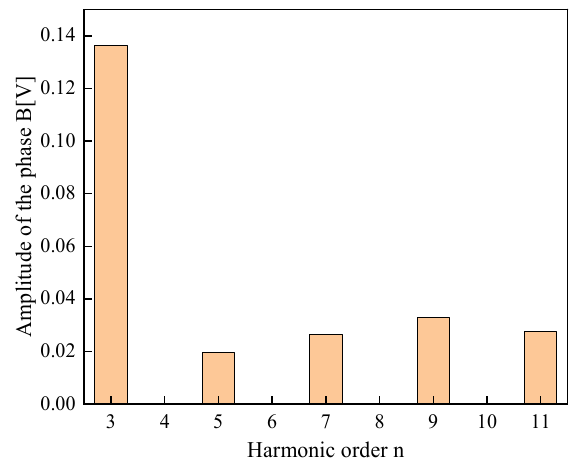
Figure 8. Harmonic of no-load back EMF of phase B.